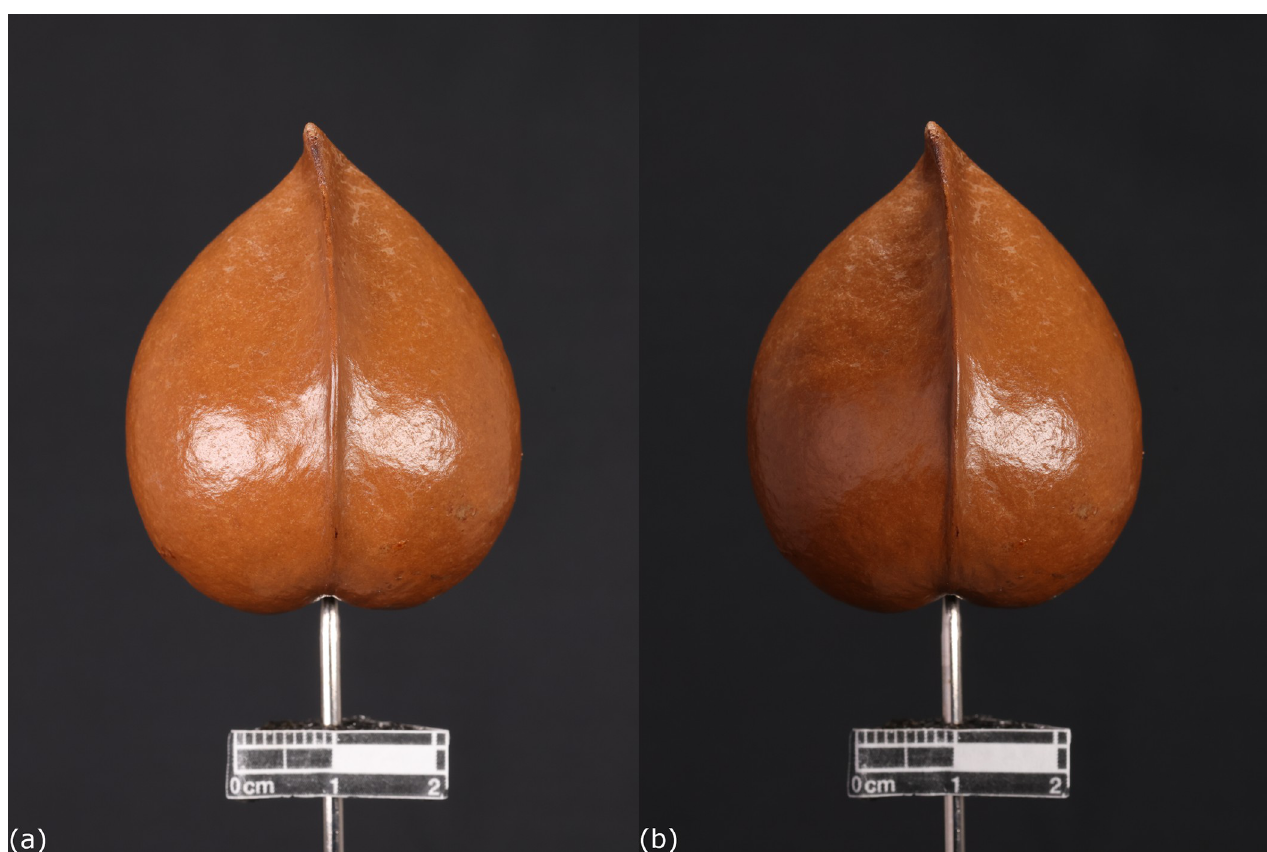
Fig 5. Light reflection on shiny surface. (a) Two light plates were placed on the left and right sides of the fruit of Heritiera littoralis Aiton (PH018) respectively. The light reflection created multiple white spots on the surface which resulted in failure of image recognition by the software. (b) A paper was added between PH018 and the left light plate, which diffused most of the direct light towards it. The light reflection on the left side was significantly reduced.